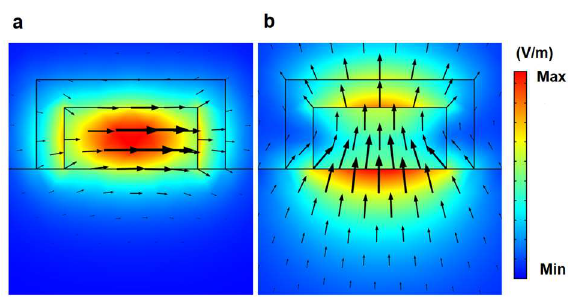
Fig. 2. Direction of the electric field. In all the points simulated the electric field vector is represented by an arrow whose components are proportional to the in-plane and out-of-plane field components. (a) Fundamental mode (TE), (b) second mode (TM).